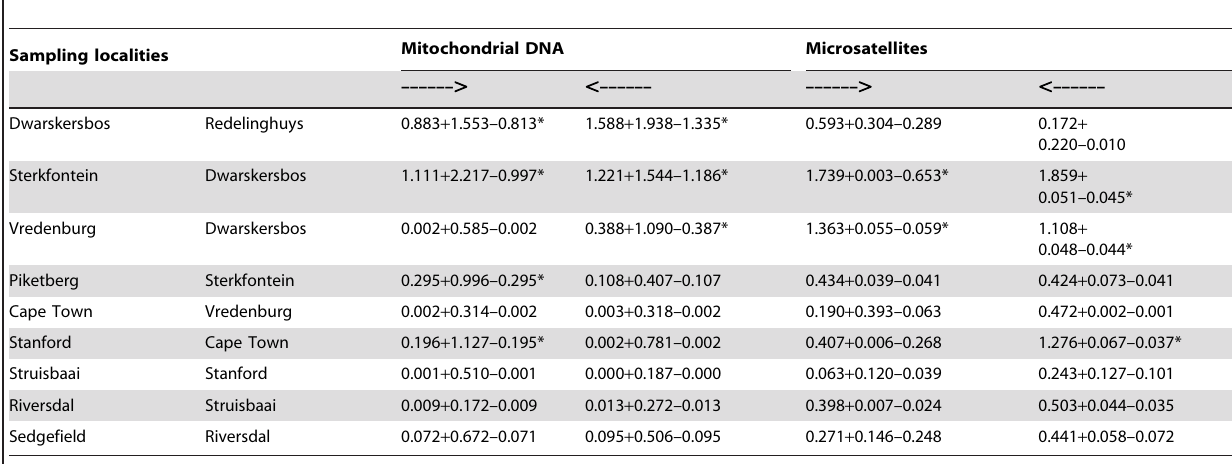
Table 3. Gene-flow values (number of individuals per generation) between the sampled B. suillus populations.